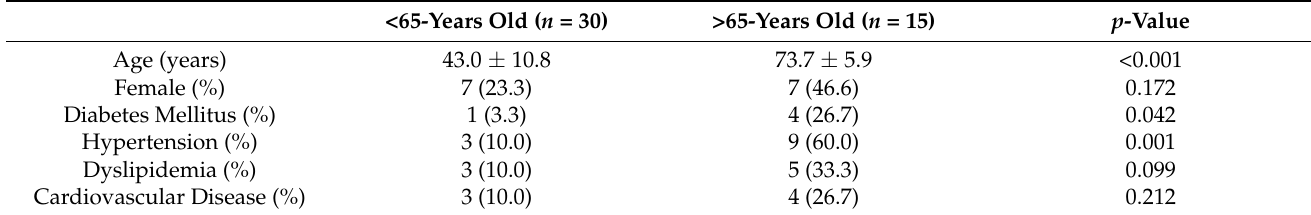
Table 1. Characteristics of the study